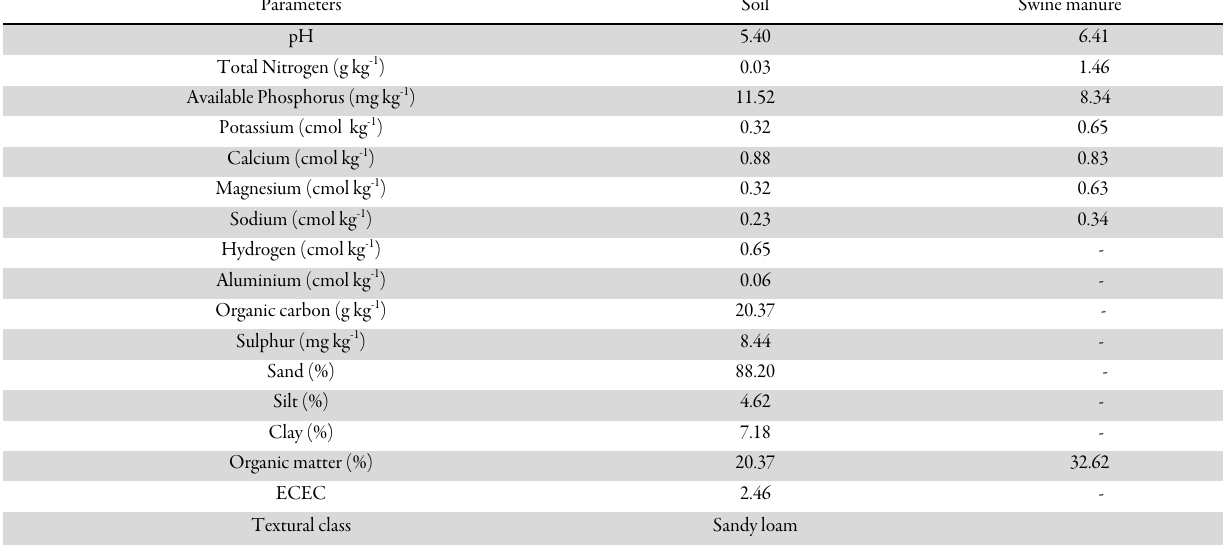
Table 1. Physical and chemical analysis of soil prior to planting and chemical properties of swine manures used